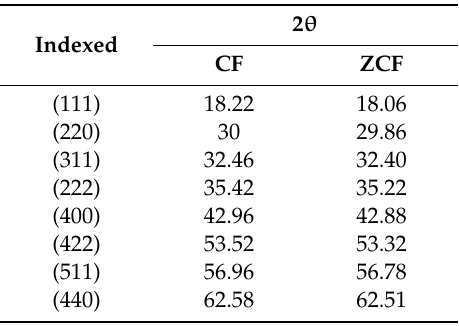
Table 1. The indexed di ff raction peaks from